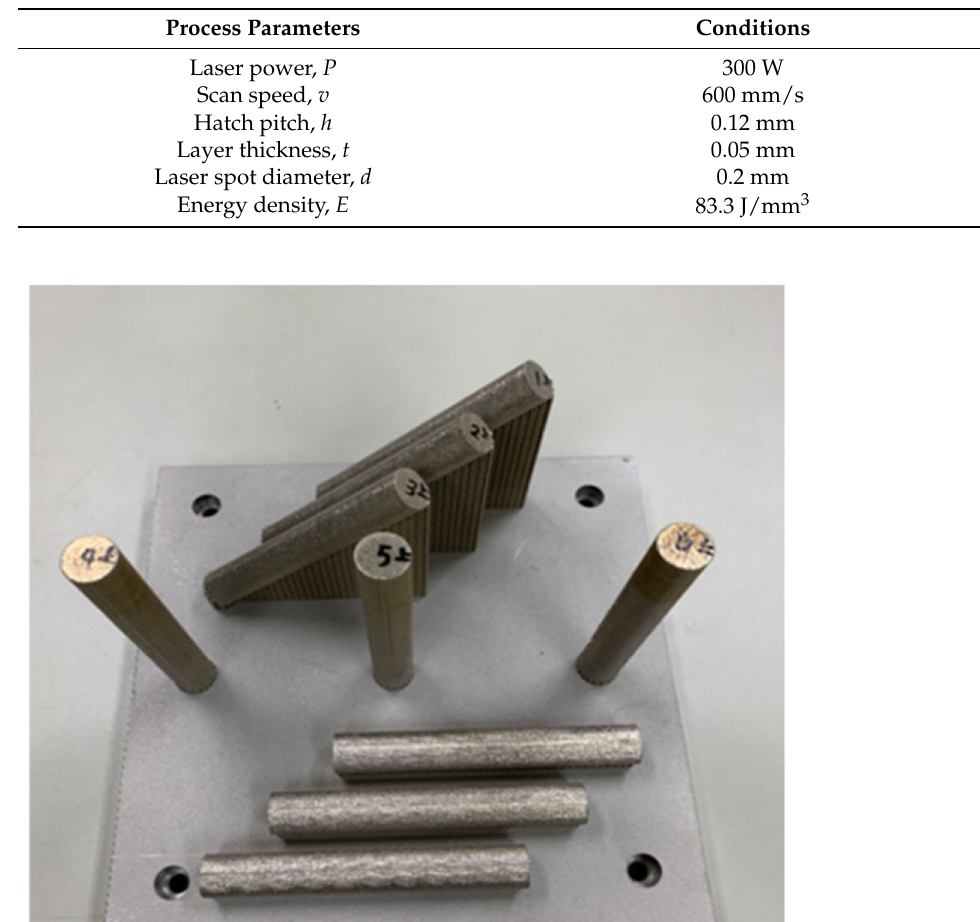
Table 4. Fabrication condition of round bars.